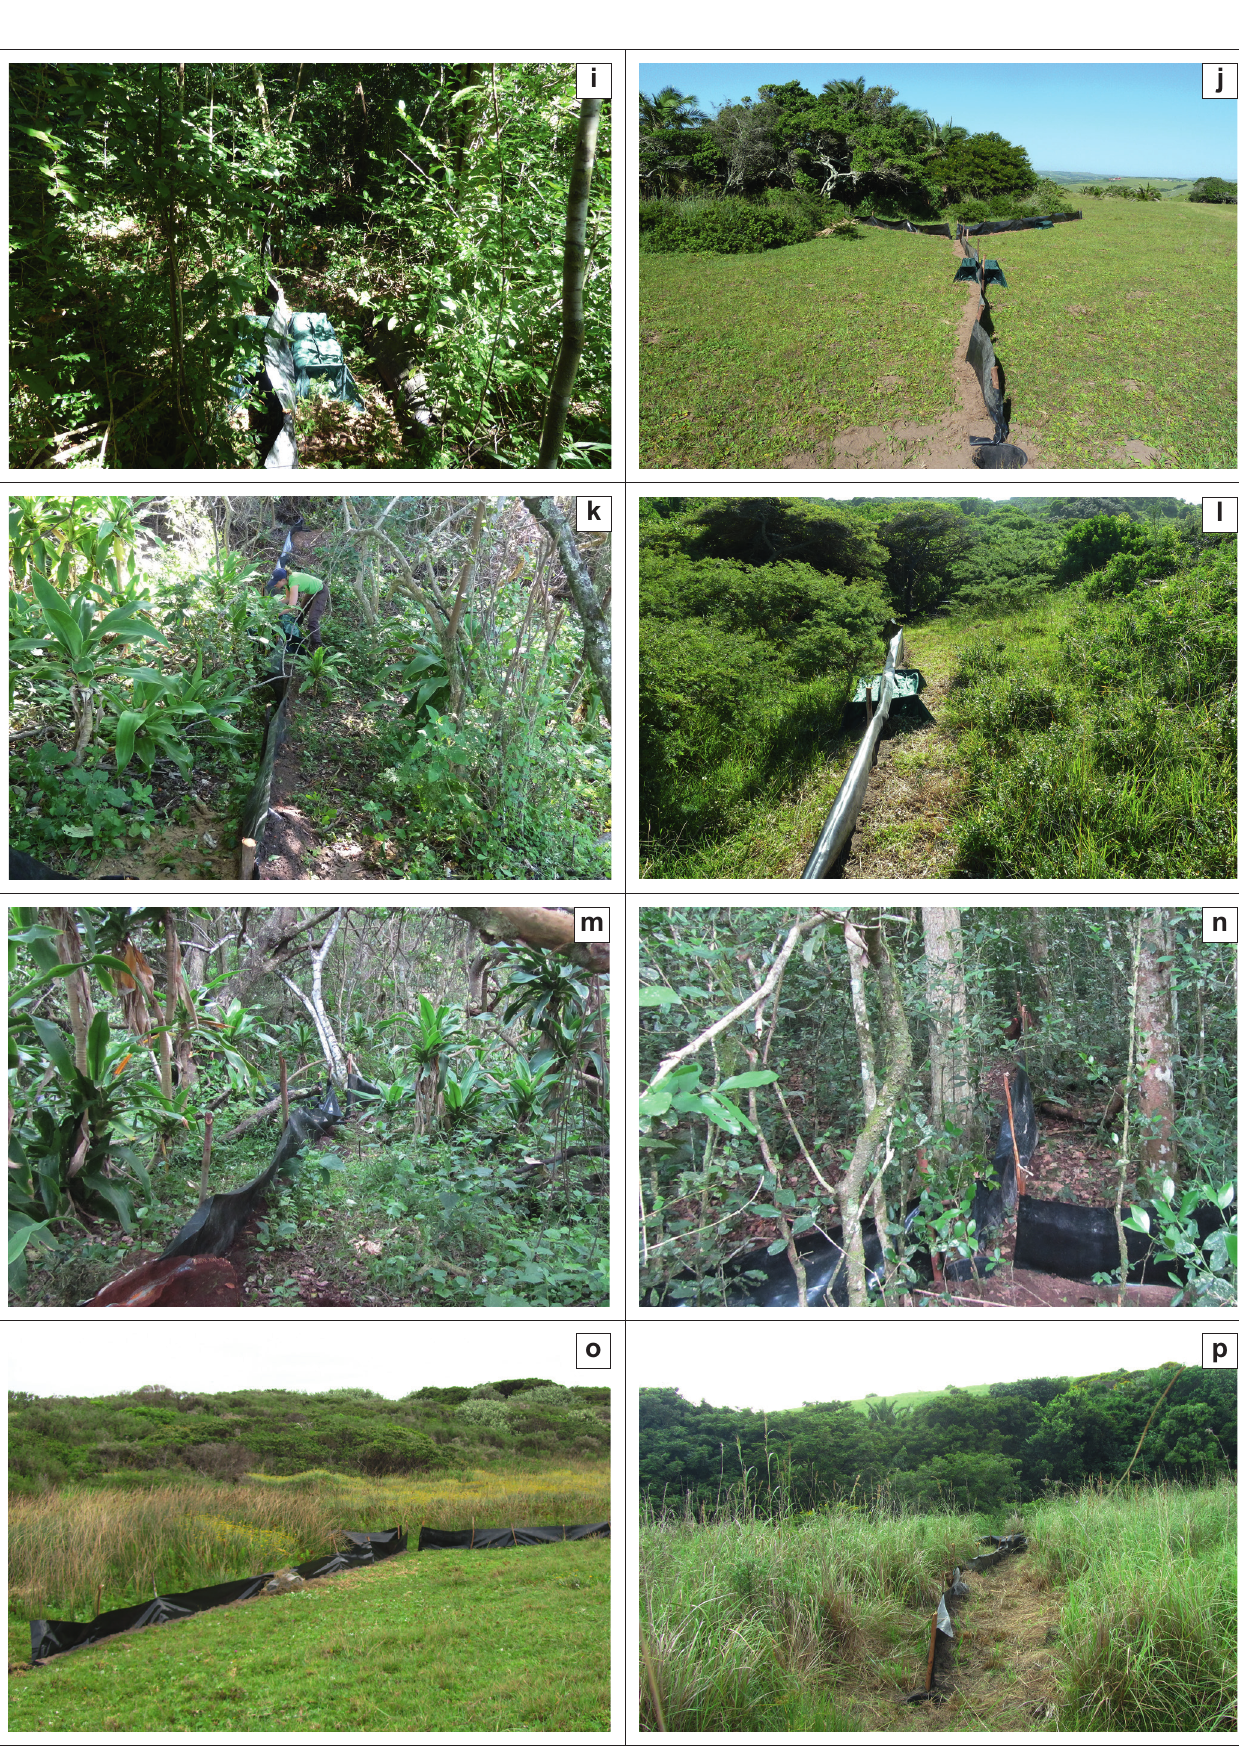
Figure 1-A4 continues on next page